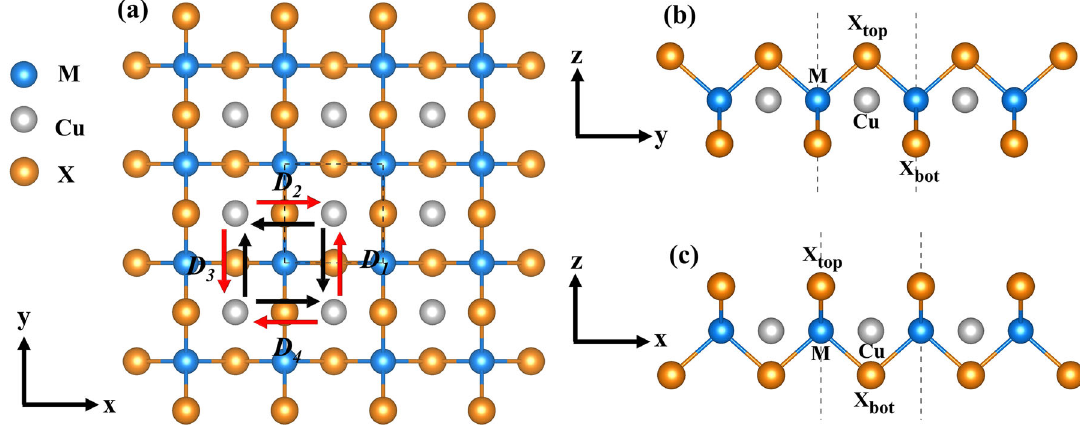
Fig. 1 Crystal structure of M Cu X 2 monolayer, where M and X represent 3 d TM and group VIA elements, respectively. Top ( a ) and side ( b , c ) views of MCuX 2 monolayer. The dashed lines in ( a – c ) represent the unit cell. The red and black arrows in ( a ) indicate the in-plane component of DMI with opposite chirality. Table 1. The calculated magnetic parameters of lattice constants a , NN, and NNN exchange coupling J 1 and J 2 , magnetic anisotropy energy K and magnetic moment μ M of M atom, and magnetic characteristic parameter R in M Cu X 2